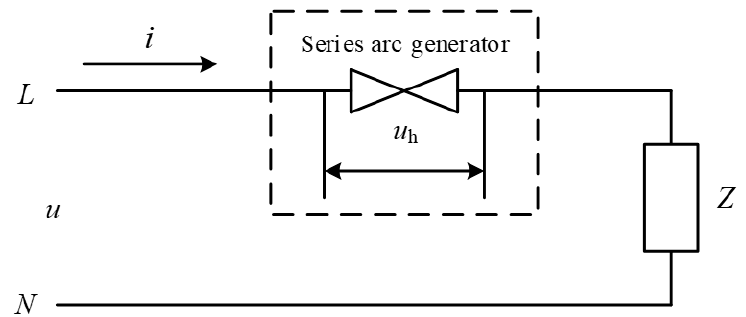
Figure 2. Test circuit of an AC series arc.